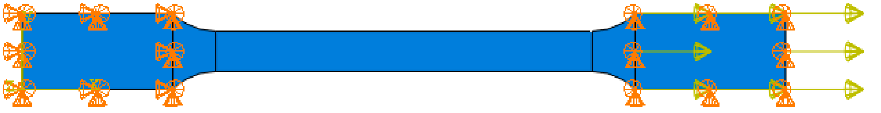
Figure 12. Boundary conditions and load.